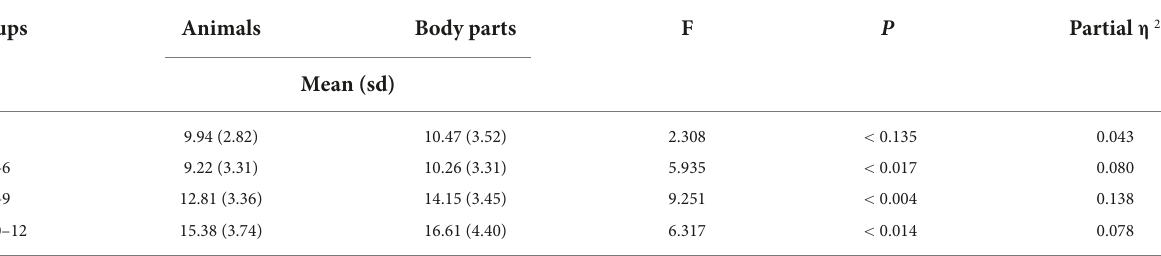
TABLE 2 Comparison between animals and body parts production (correct words).